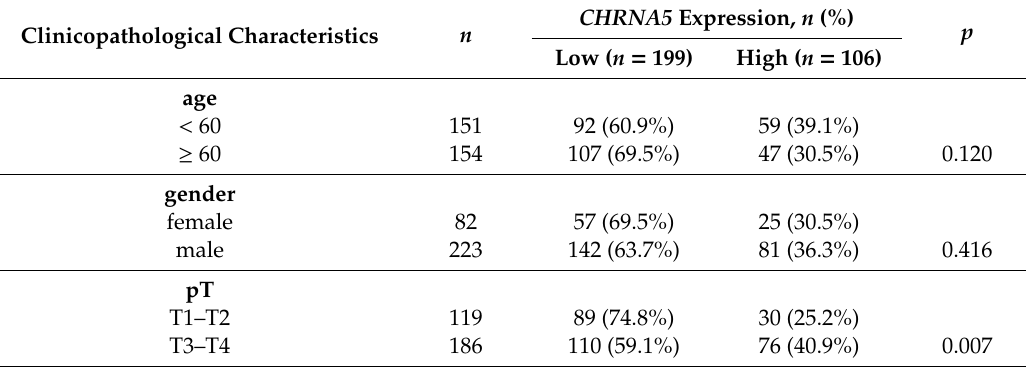
Table 2. Relationship between CHRNA5 expression and the clinicopathological characteristics of the TCGA cohort with head and neck